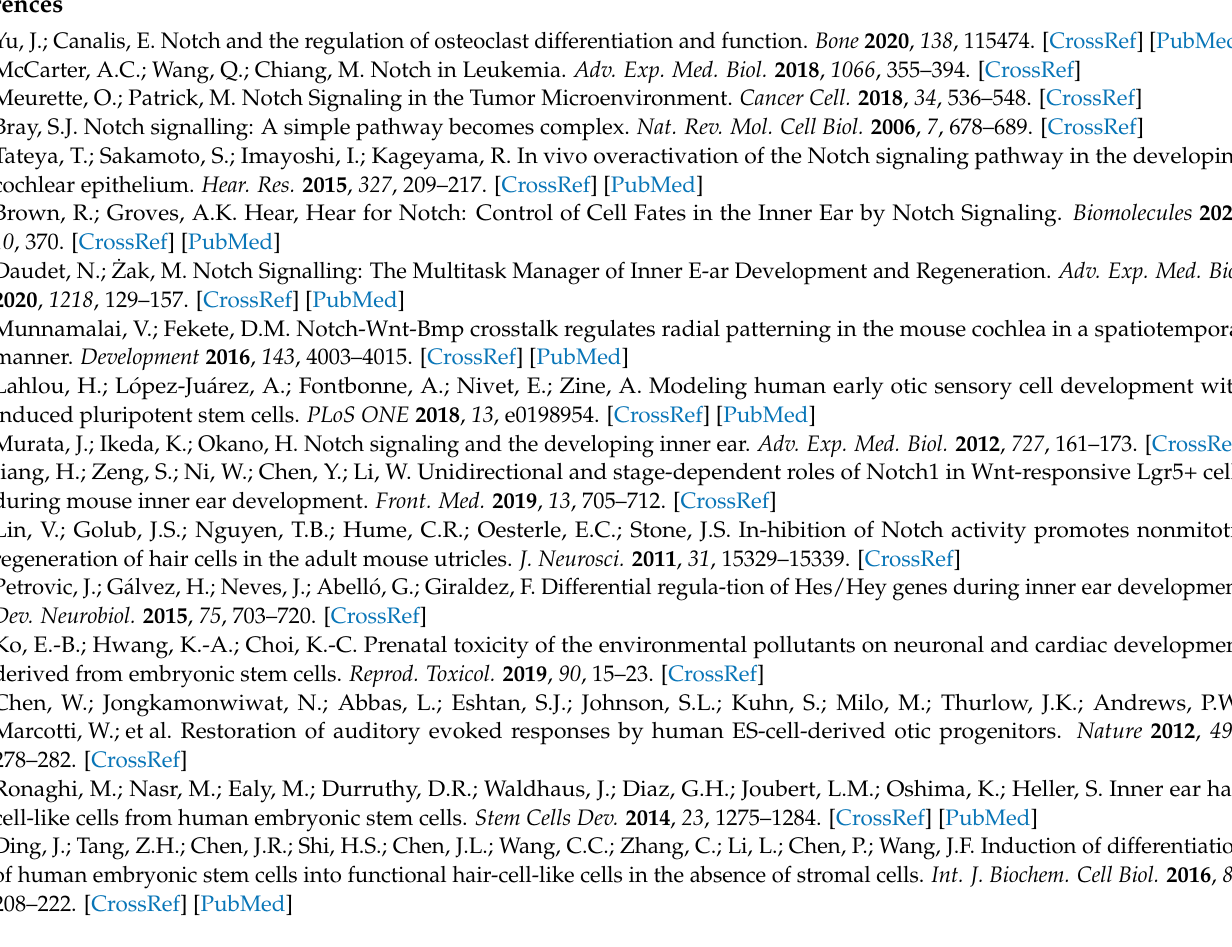
sequence, Figure S1: Efficiency of shRNA vectors, Figure S2: Infection efficiency of lentiviruses harboring shRNA, Figure S3: Identification of cells stably infected by the